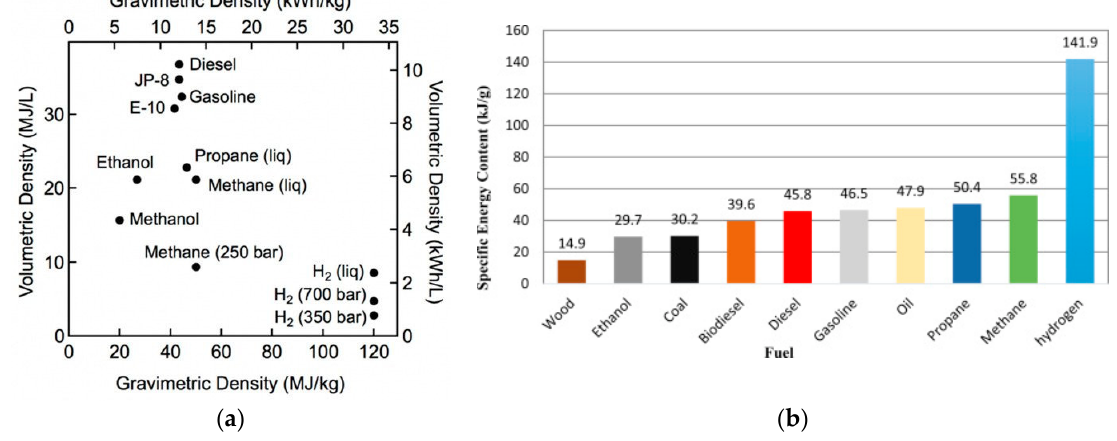
Figure 4. Hydrogen properties, ( a ) volumetric and gravimetric density of hydrogen, ( b ) specific energy density compared to other fuels. Reprinted with permission [27,28].